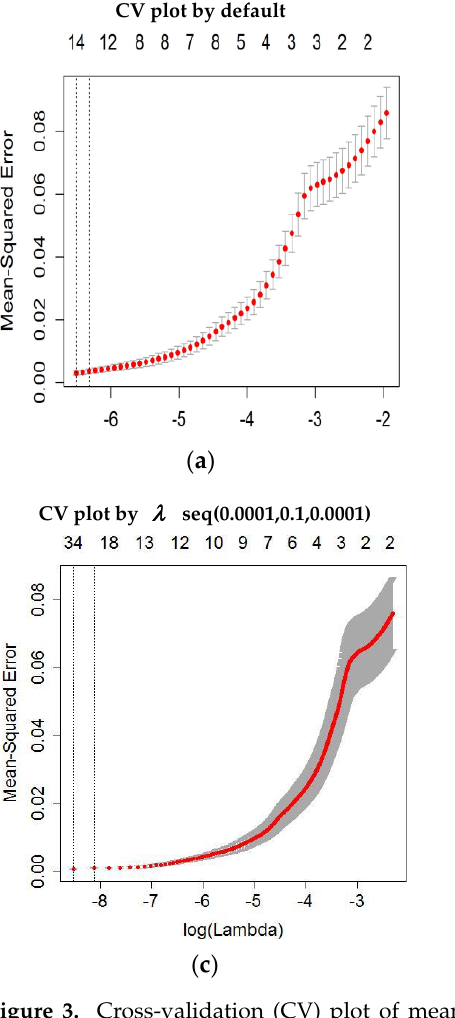
parameter λ ( a ) by default using the glmnet package in R, and with a range of λ sequences: ( b ) seq(0, 1, Figure 3. Cross-validation (CV) plot of mean squared error (MSE) corresponding to smoothing 0.0001), ( c ) seq(0.0001, 0.1, 0.0001), and ( d ) seq(0.0001, 0.01, 0.0001). parameter  ( a ) by default using the glmnet package in R, and with a range of  sequences: ( b )